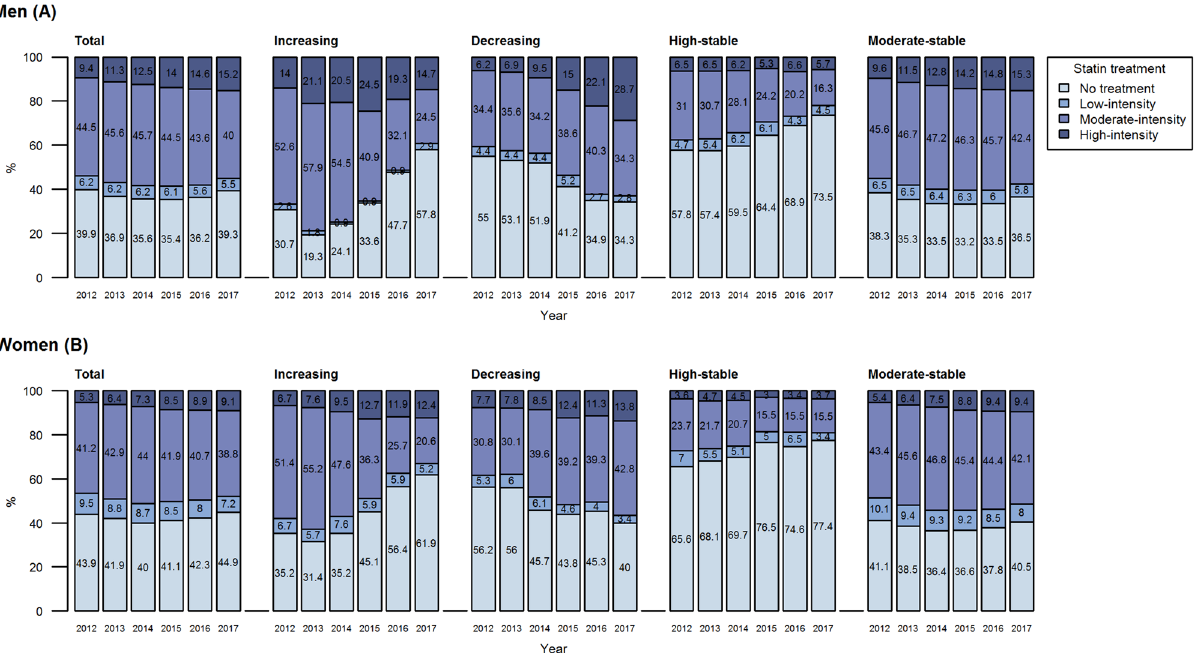
Figure 2. Annual statin treatment (%) by trajectory group for men ( A ) and women ( B ) (2012–2017). Each year’s plot only includes patients who were alive and living in North Karelia by 31 Dec. The number of patients by trajectory group and year is shown for men and women in Supplementary Table